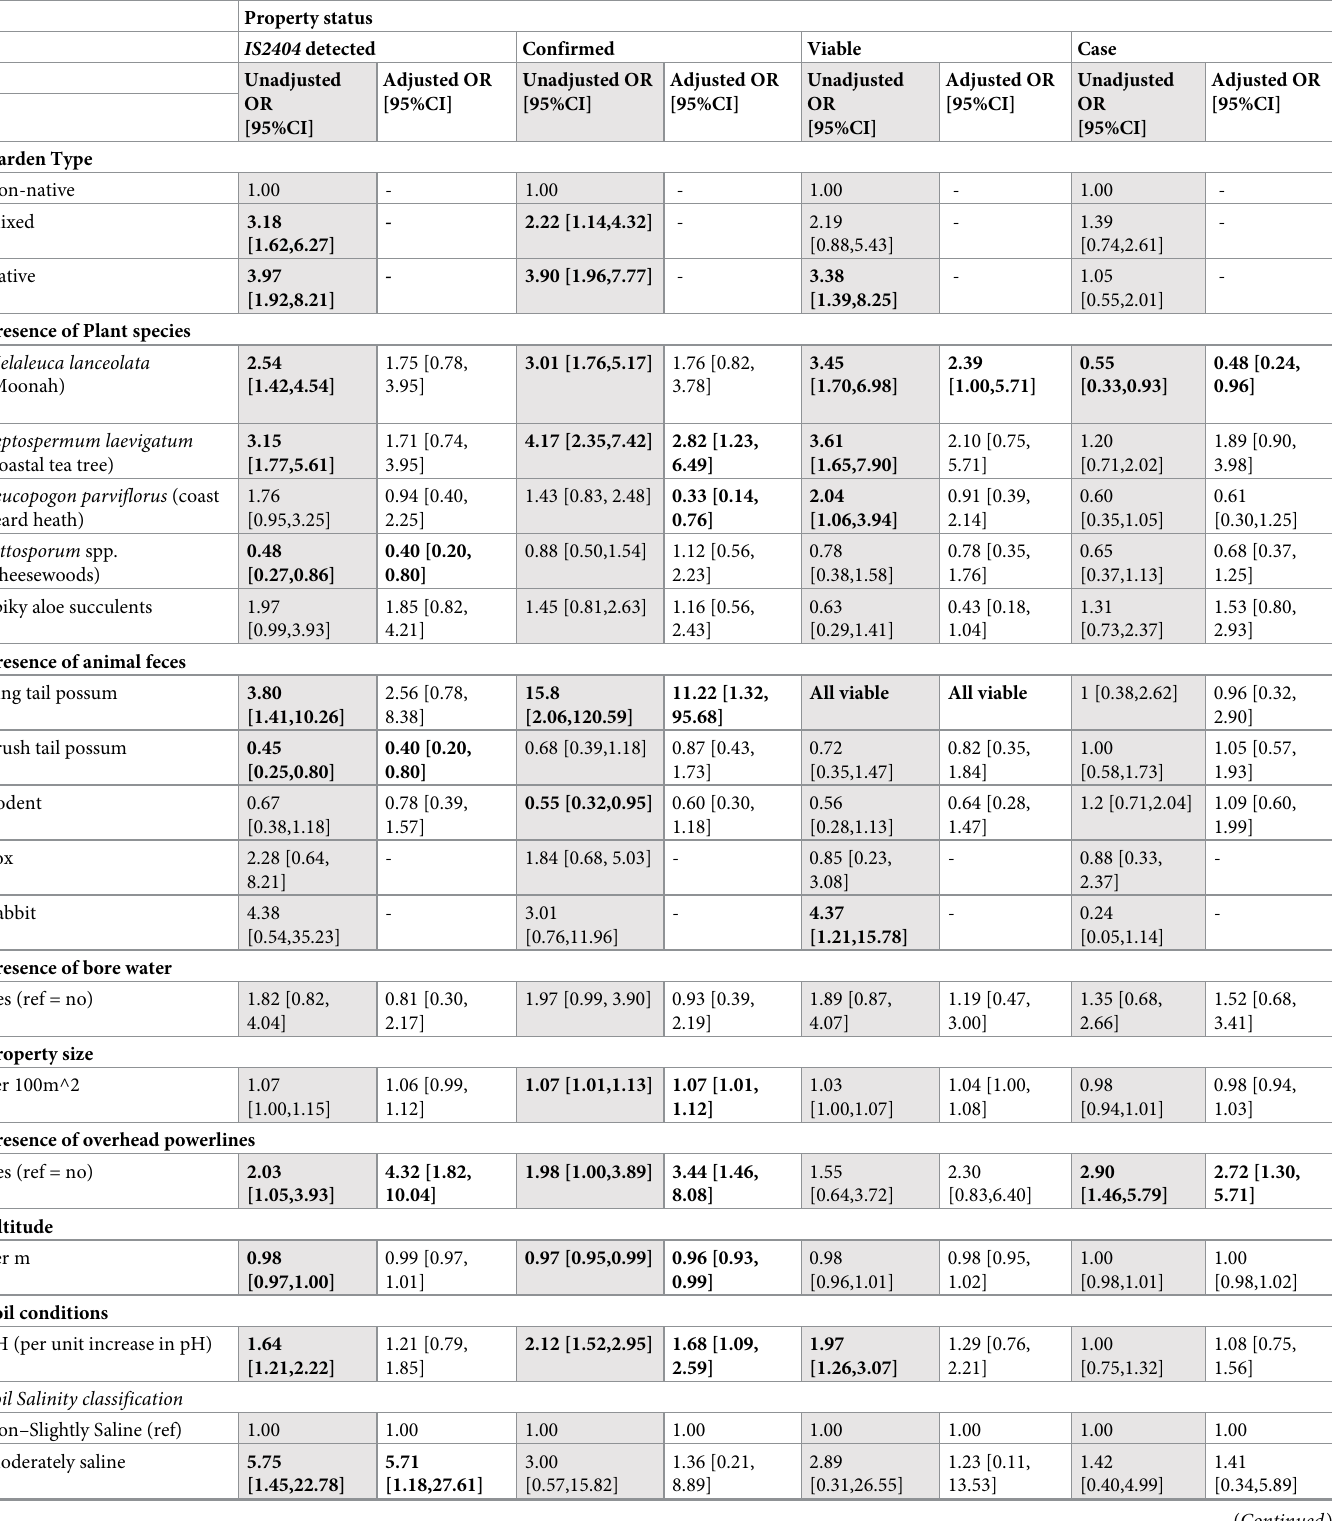
Table 3. Relationships between environmental characteristics and MU property status ( IS2404 positive, confirmed, viable) or case